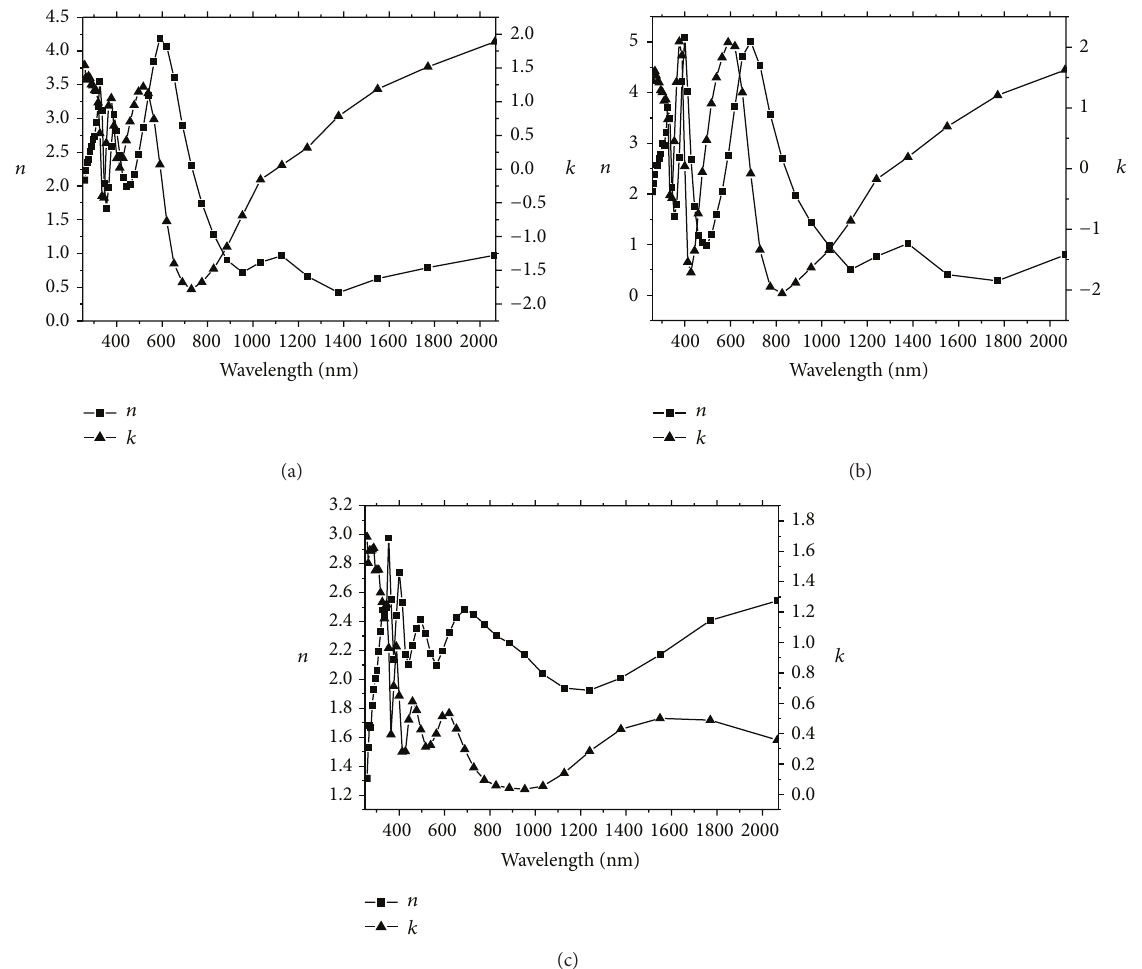
Figure 4: Refractive index ( 𝑛 ) and extinction coefficient ( 𝑘 ) versus wavelength: (a) sample 1, (b) sample 2, and (c) sample 3.